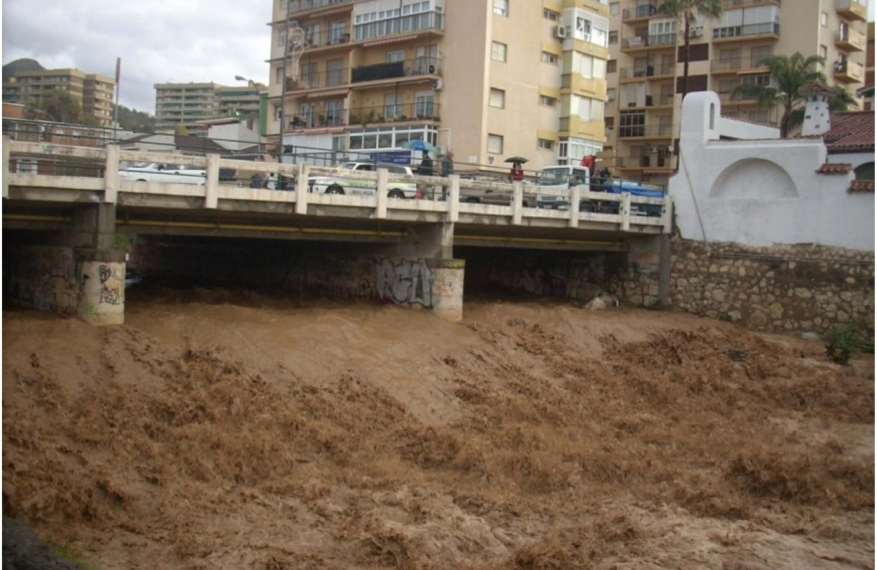
Figure 3. Photograph of one of the bridges near the Jaboneros stream mouth, after a storm, on 7 January